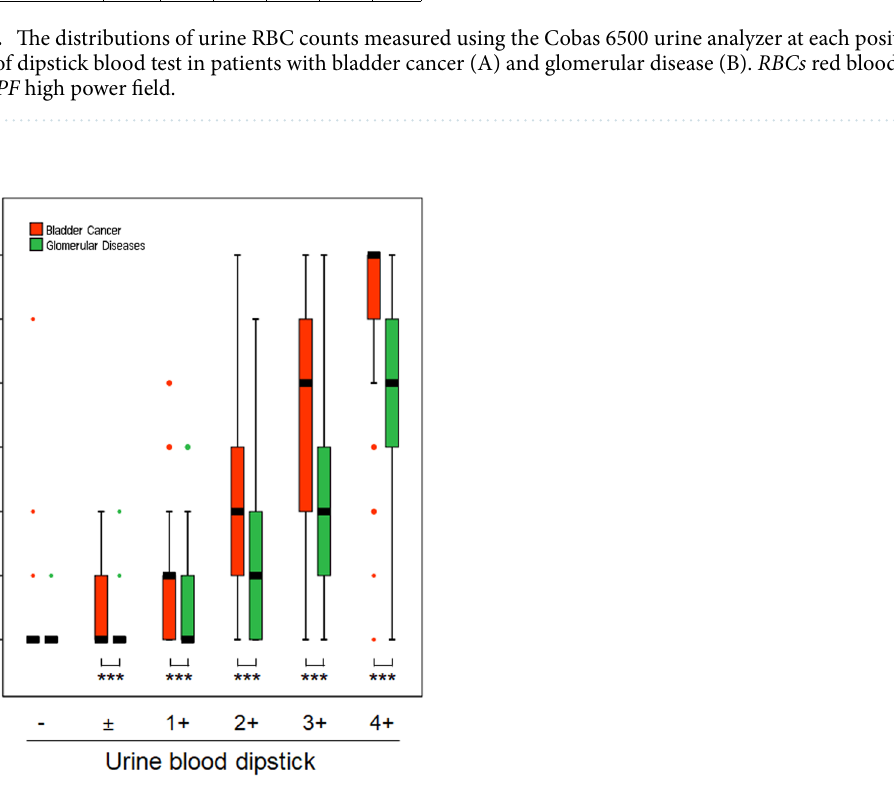
Figure 2. Comparison of hematuria grades measured using the UF-1000i urine analyzer between bladder cancer and glomerular disease at each positive dipstick grade. Vertical boxes, error bars, and dots represent the median with interquartile range, minimum and maximum values, and outliers, respectively (***p <